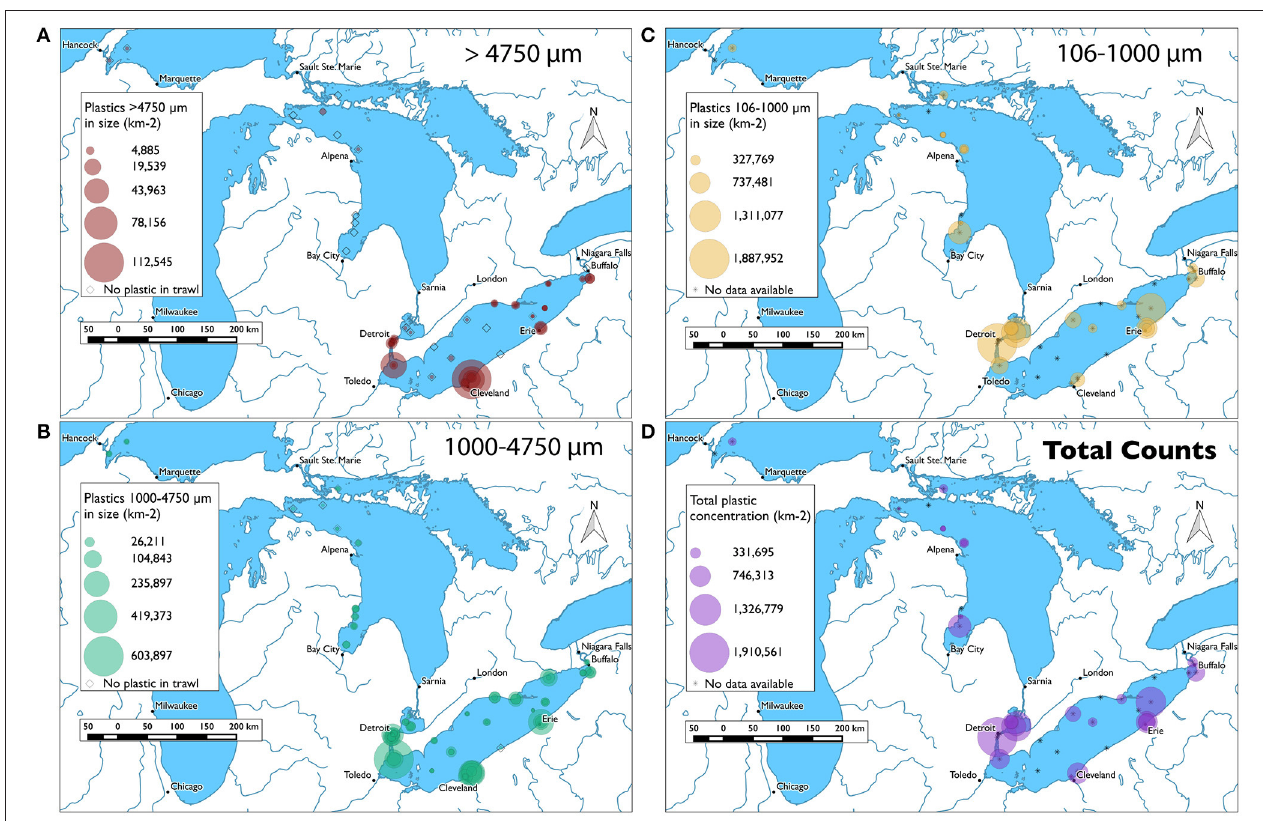
FIGURE 3 | Maps of plastic concentrations across the lakes sampled, where magnitude of concentration is depicted by size of circle around trawl location. Note, fiber counts are not included in these figures, as discussed below. (A) Mapped counts of plastic litter > 4,750 µ m. (B) Mapped counts of plastic litter 1,000–4,750 µ m. (C) Mapped counts of plastic litter 106–1,000 µ m. (D) Total mapped counts for the stations where all three size classes were